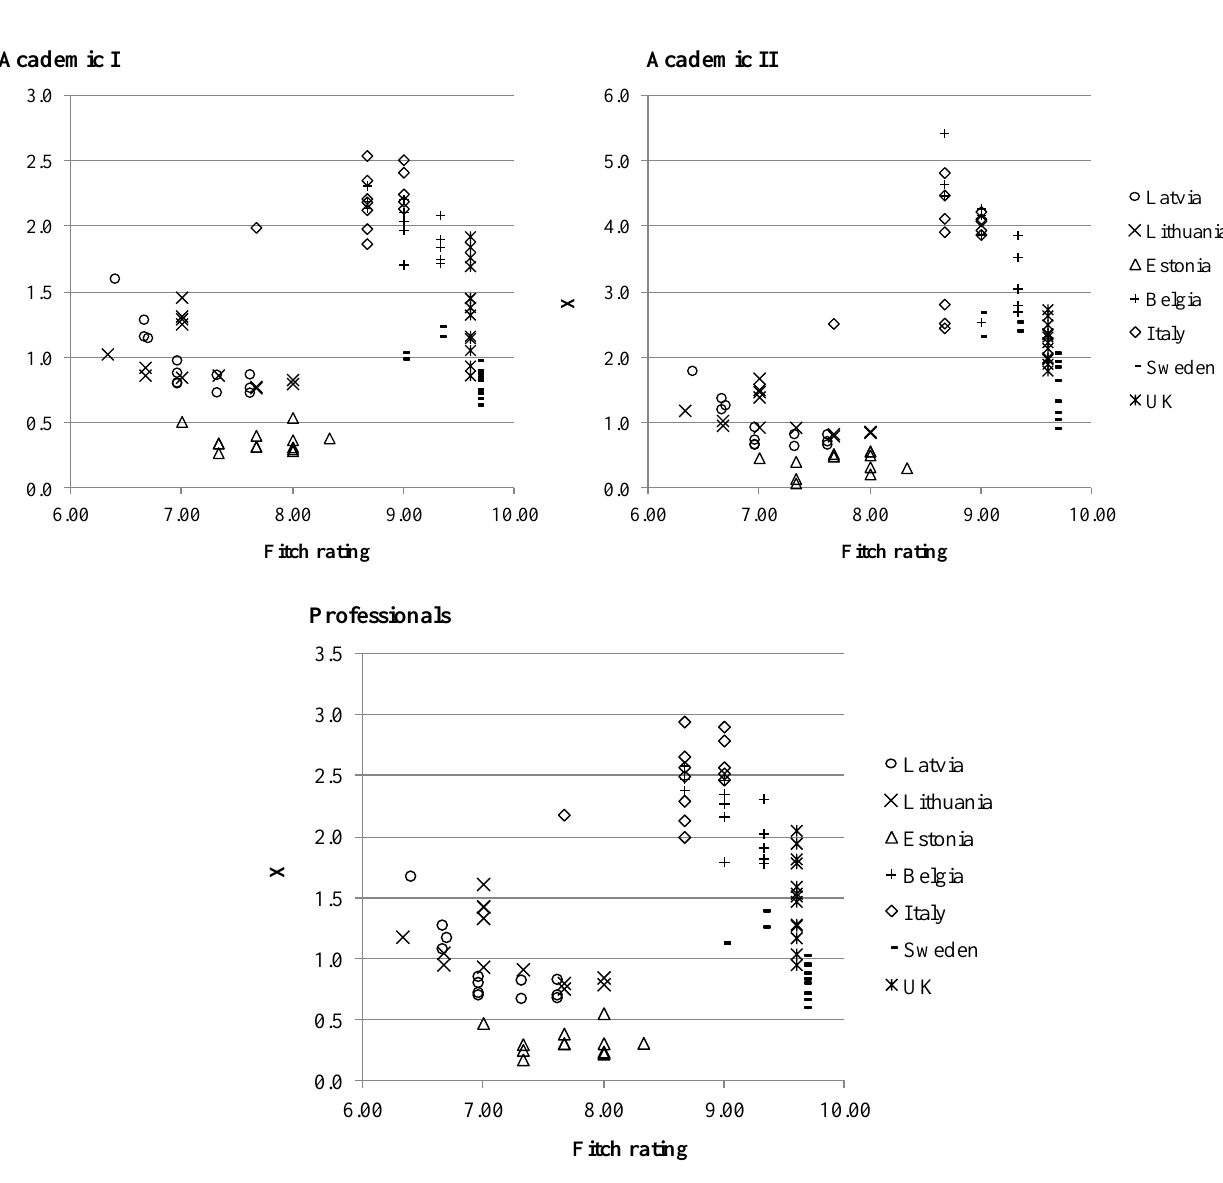
Fig. 4. Correlation between X indicator calculated using weight coefficients from different expert groups and sovereign Fitch